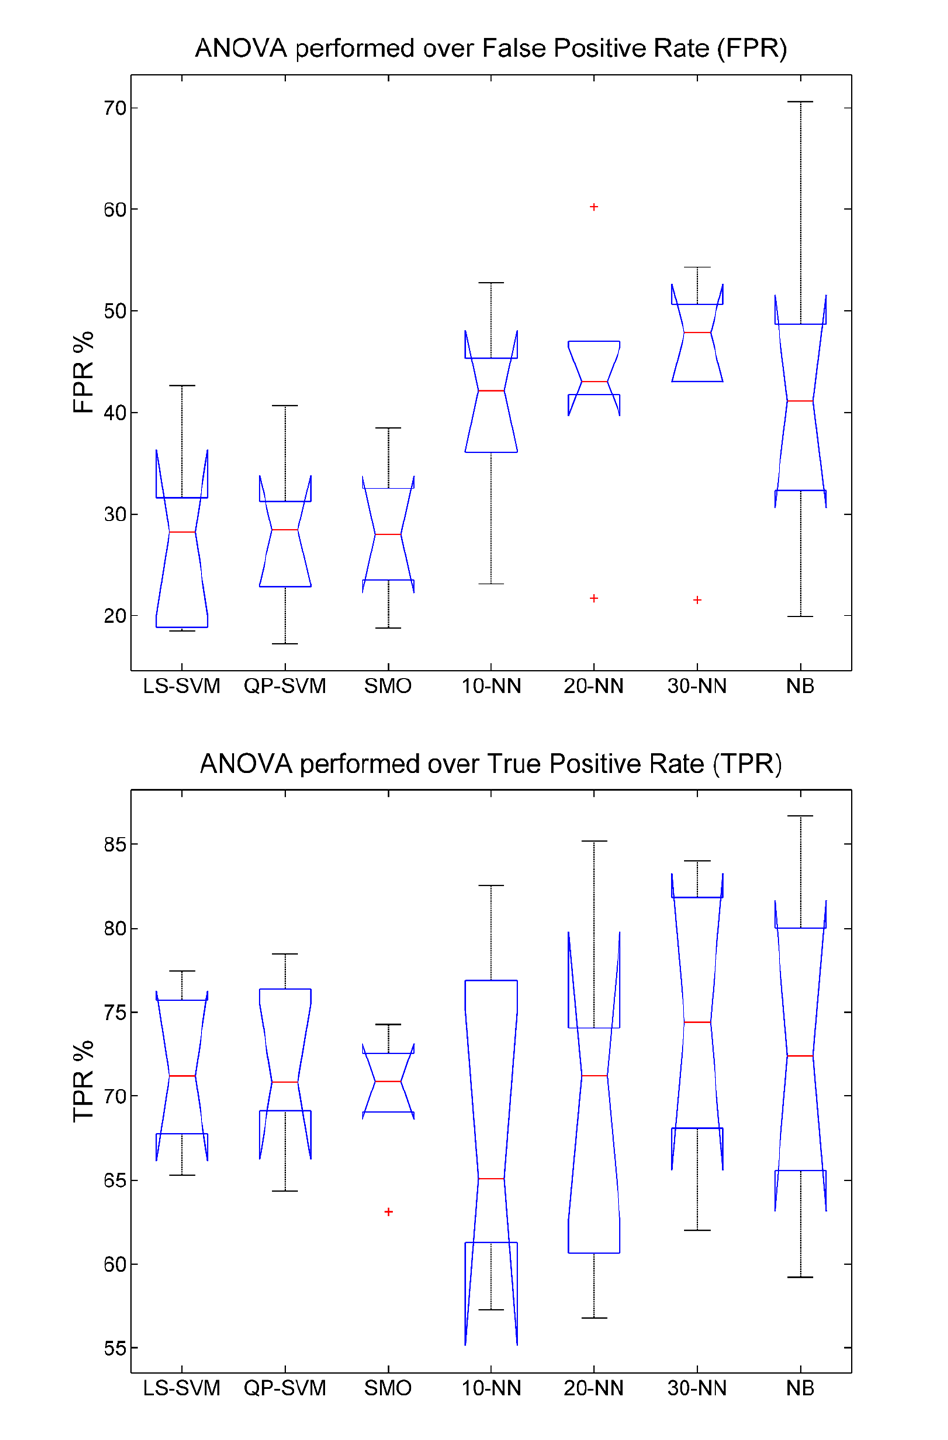
Figure 6. ANOVA results for false positive rate (FPR) ( top ) and true positive rate (TPR) ( bottom ) over all users. p -value = 0.0225 and p -value = 0.8774,